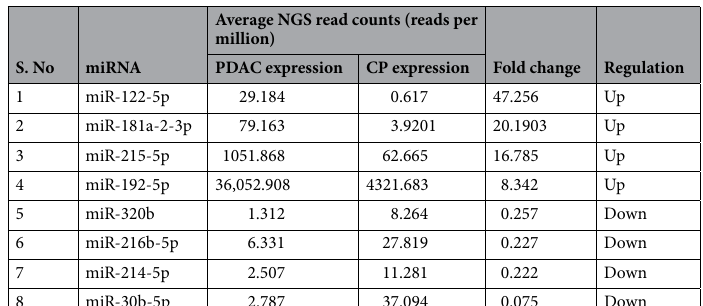
Average NGS read counts (reads per